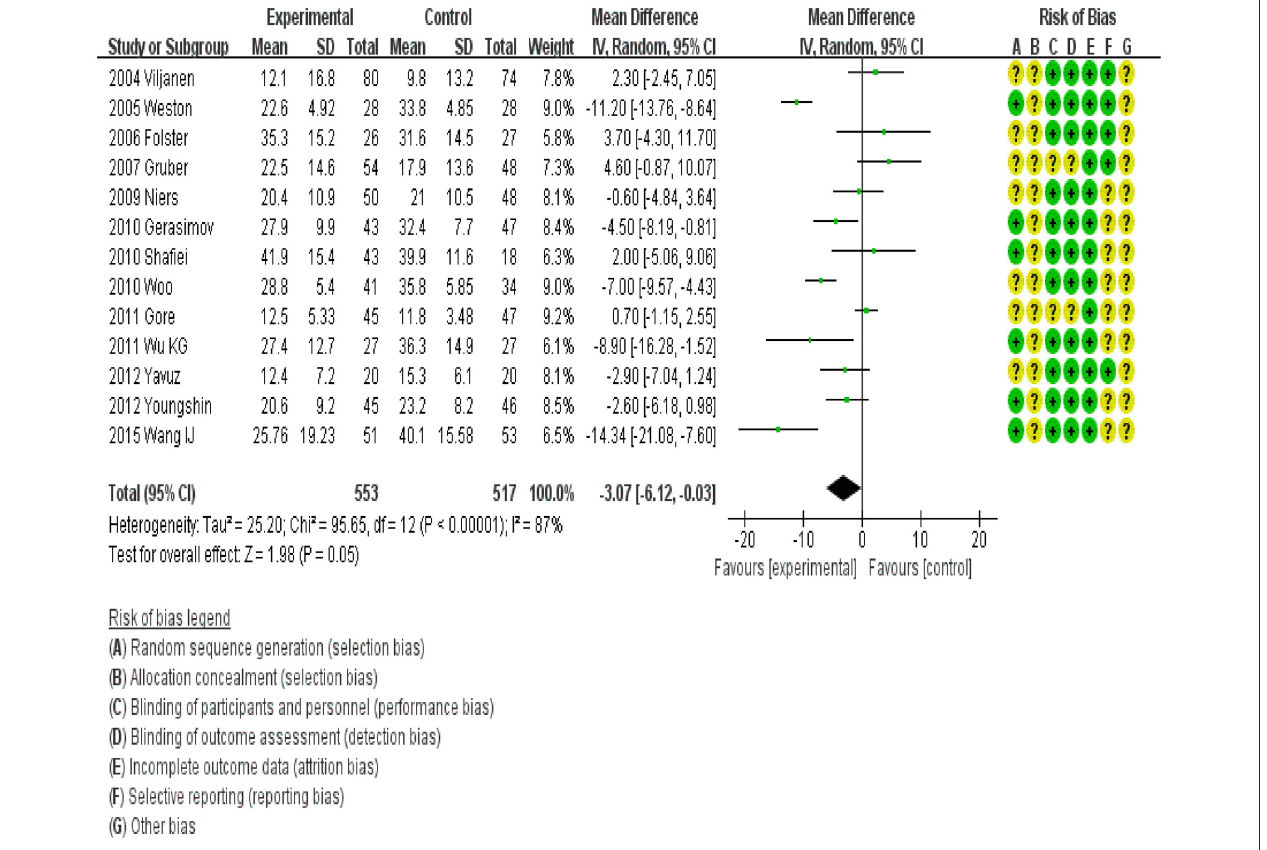
Frontiers in Cellular and Infection Microbiology |